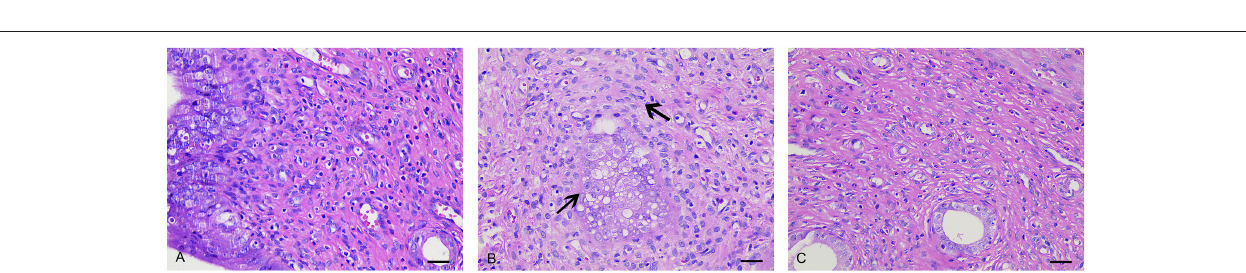
FIGURE 2 | Histopathologic examinations of uteruses from the NC, UL, and CRSR groups. The original magnification was 400 × . Scale bar: 30 µ m. (A) NC, normal control group; (B) UL, uterine leiomyoma model group; (C) CRSR, Curcumae Rhizoma and Sparganii Rhizoma treatment